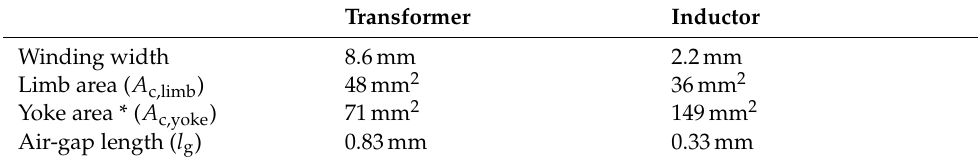
Table 4. Design characteristics of the optimized transformer and inductor. Transformer